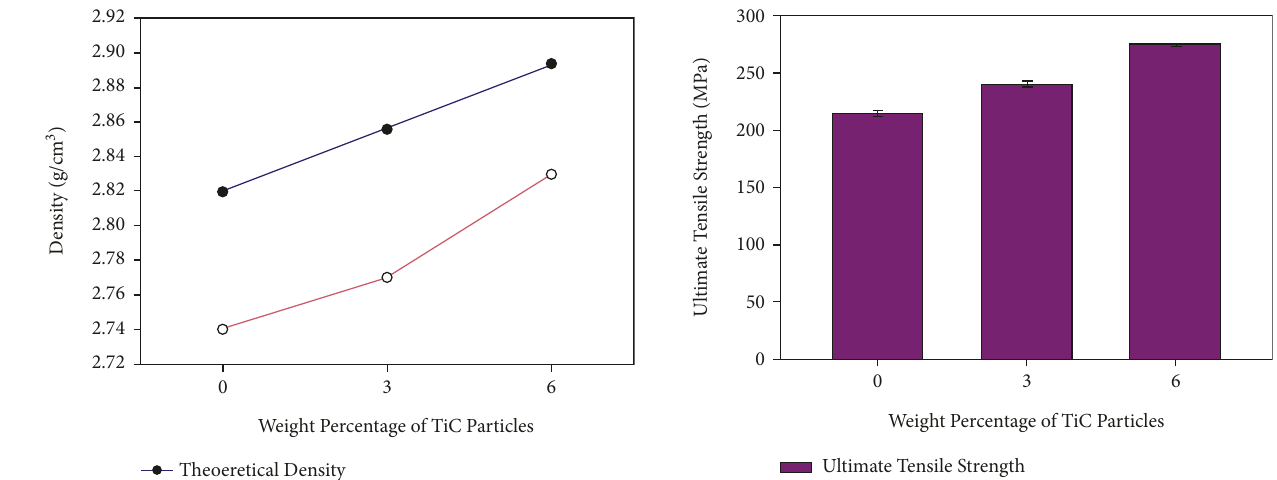
Figure 8: Ultimate strength of Al7075 alloy with TiC